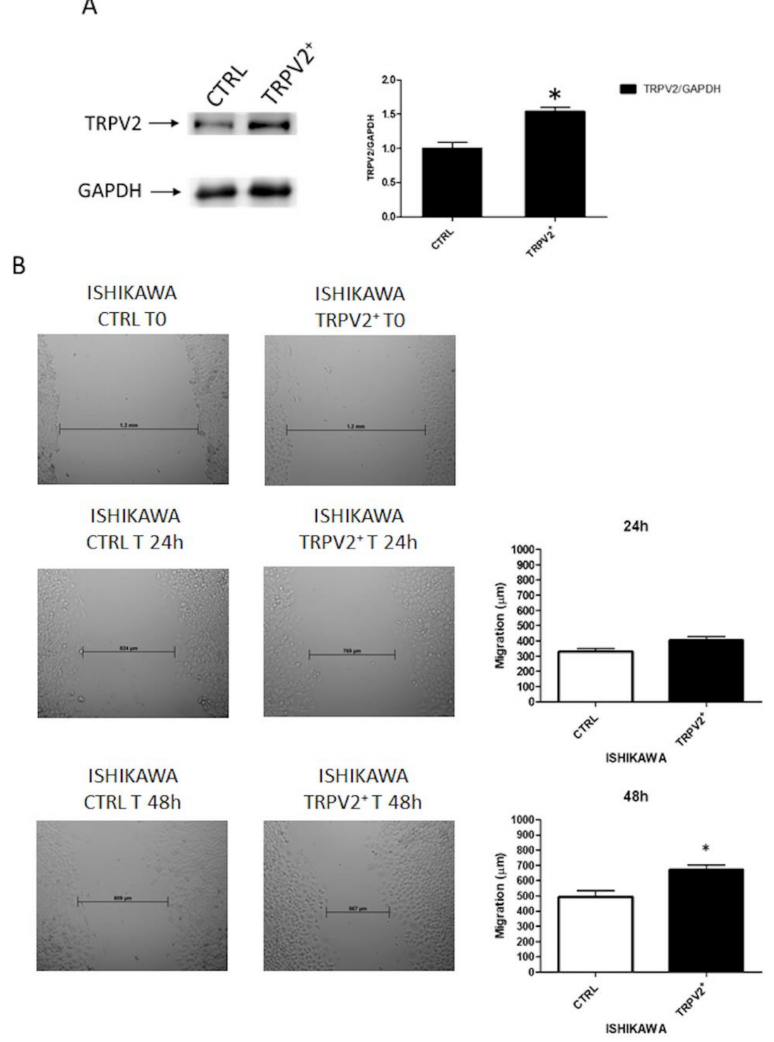
Figure 5. TRPV2 over-expression enhanced migration of EC cells. ( A ) Western blot analysis of TRPV2 and GAPDH protein levels in untransfected (CTRL) and TRPV2-transfected Ishikawa cells. Blots are representative of one of three separate experiments. TRPV2 densitometry values were normalized to GAPDH used as loading control and normalized. Densitometric values shown are the mean ± SD of three separate experiments. * p < 0.05 vs. control cells. ( B ) Wound-healing assays for Ishikawa cells after TRPV2 over-expression. All experiments were repeated three times. Data are presented as the mean ± SD. * p < 0.05 vs.